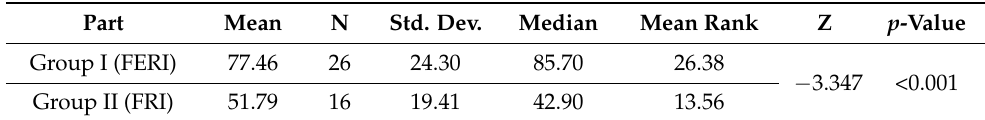
Table 4. Comprehension correctness of the second test (Mann–Whitney